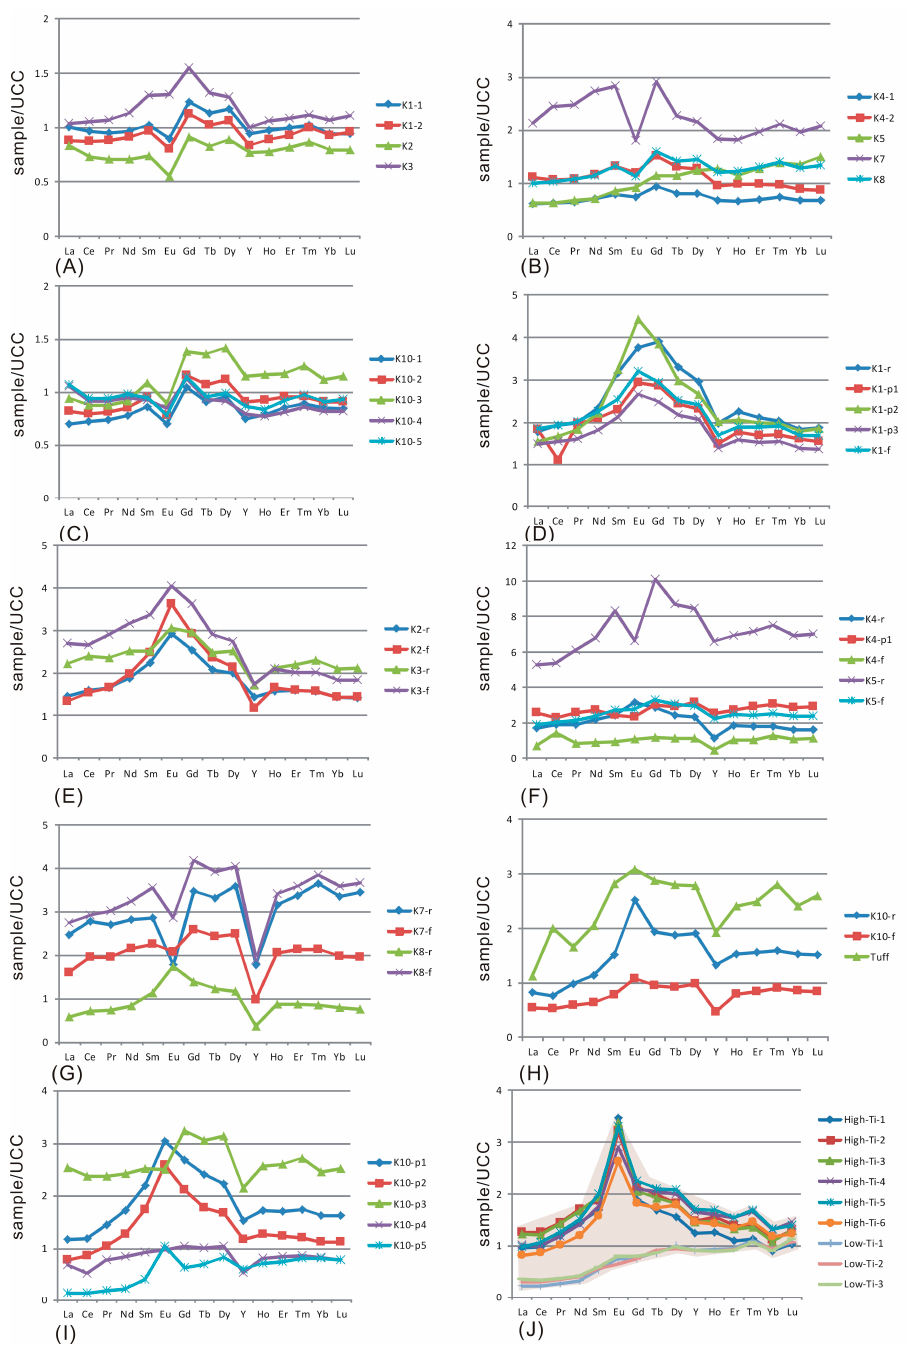
Figure 9. Upper Continental Crust-normalized REY patterns of samples from the Zhongliangshan coals ( A – C ); non-coal bands ( D – I ); and Emeishan high-Ti and low-Ti basalts ( J ). Note: the data of high-Ti and low-Ti are from Huang et al. [67].